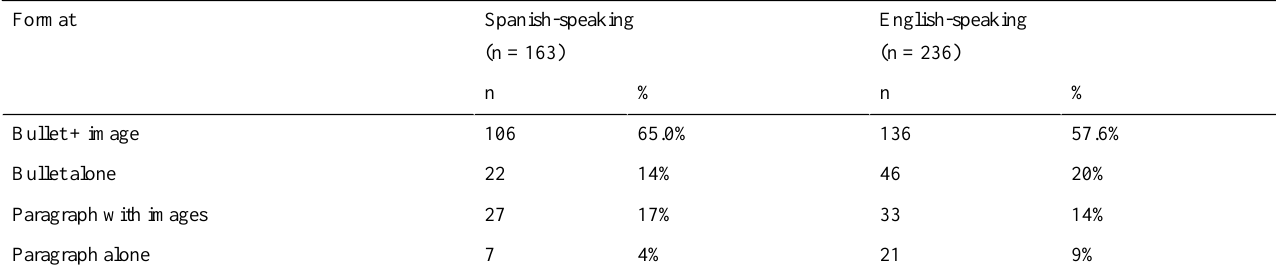
Table 3. Comparison of format preferences Spanish-speaking and English-speaking survey participants (total n =